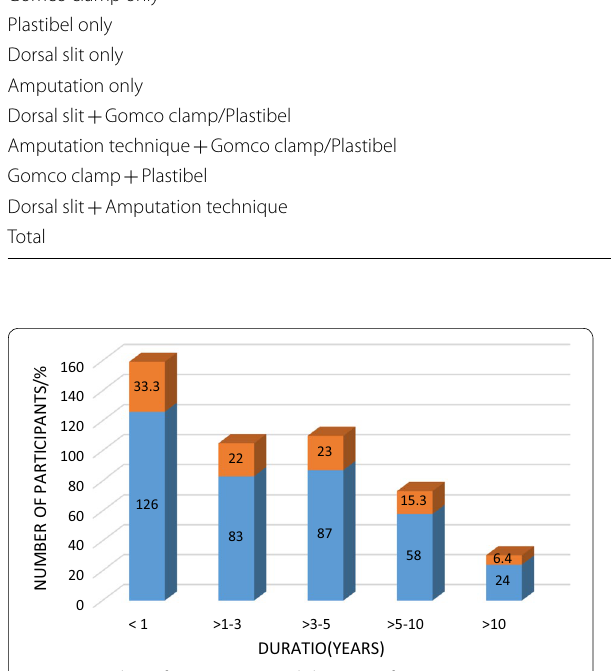
Fig. 1 Number of participants and duration of